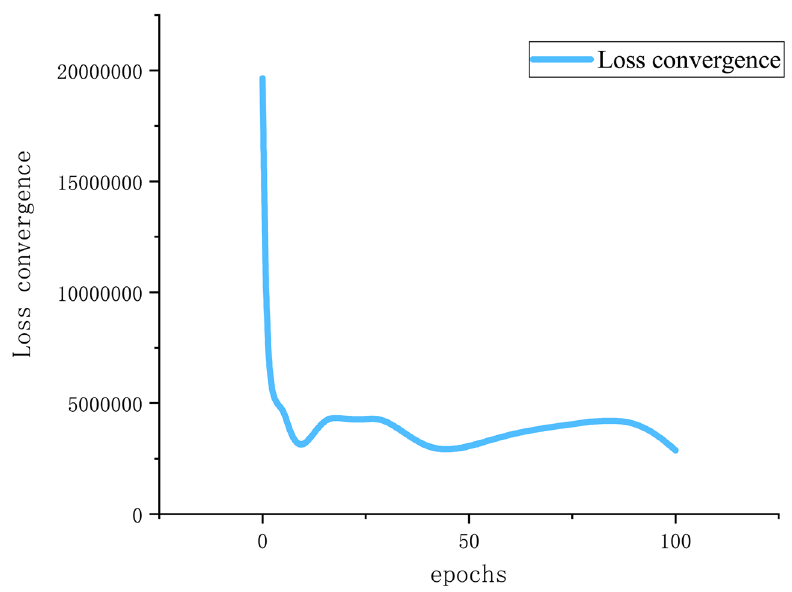
Figure 5. Loss convergence with different epochs.